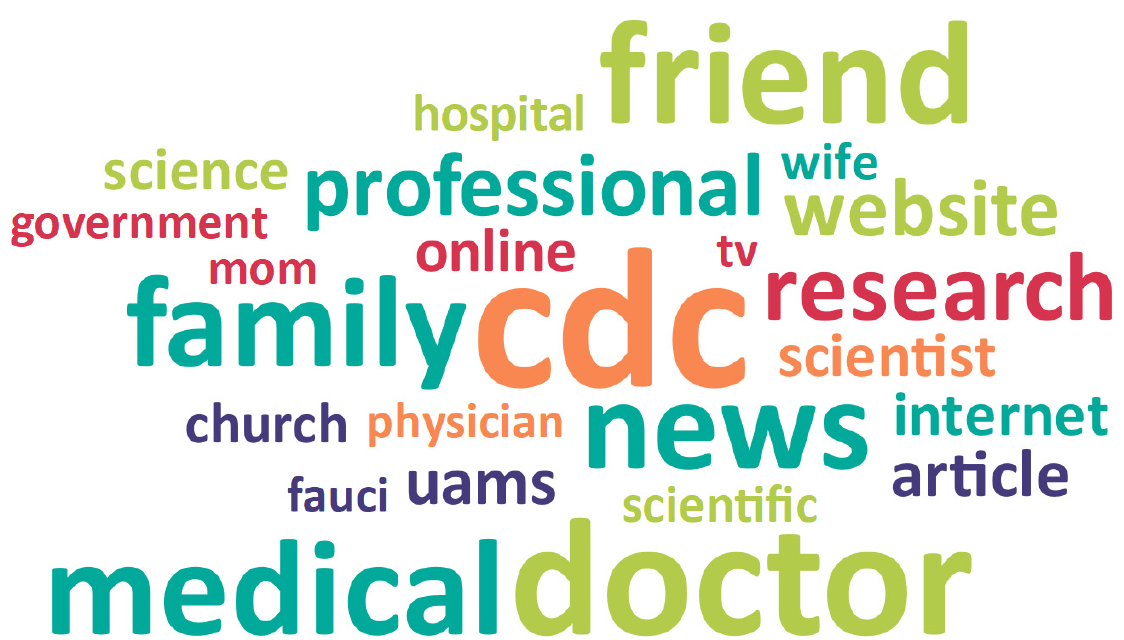
Figure 1. Word Cloud representation of trusted sources of information about COVID-19 vaccine.